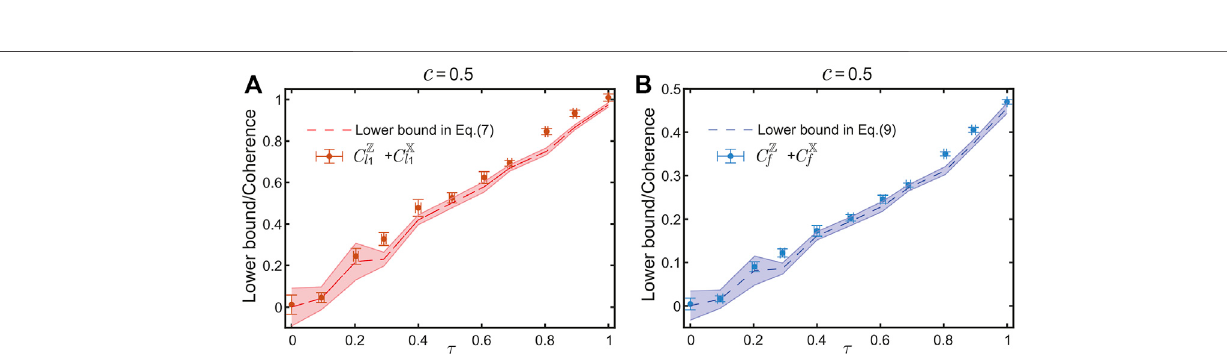
Frontiers in Physics |